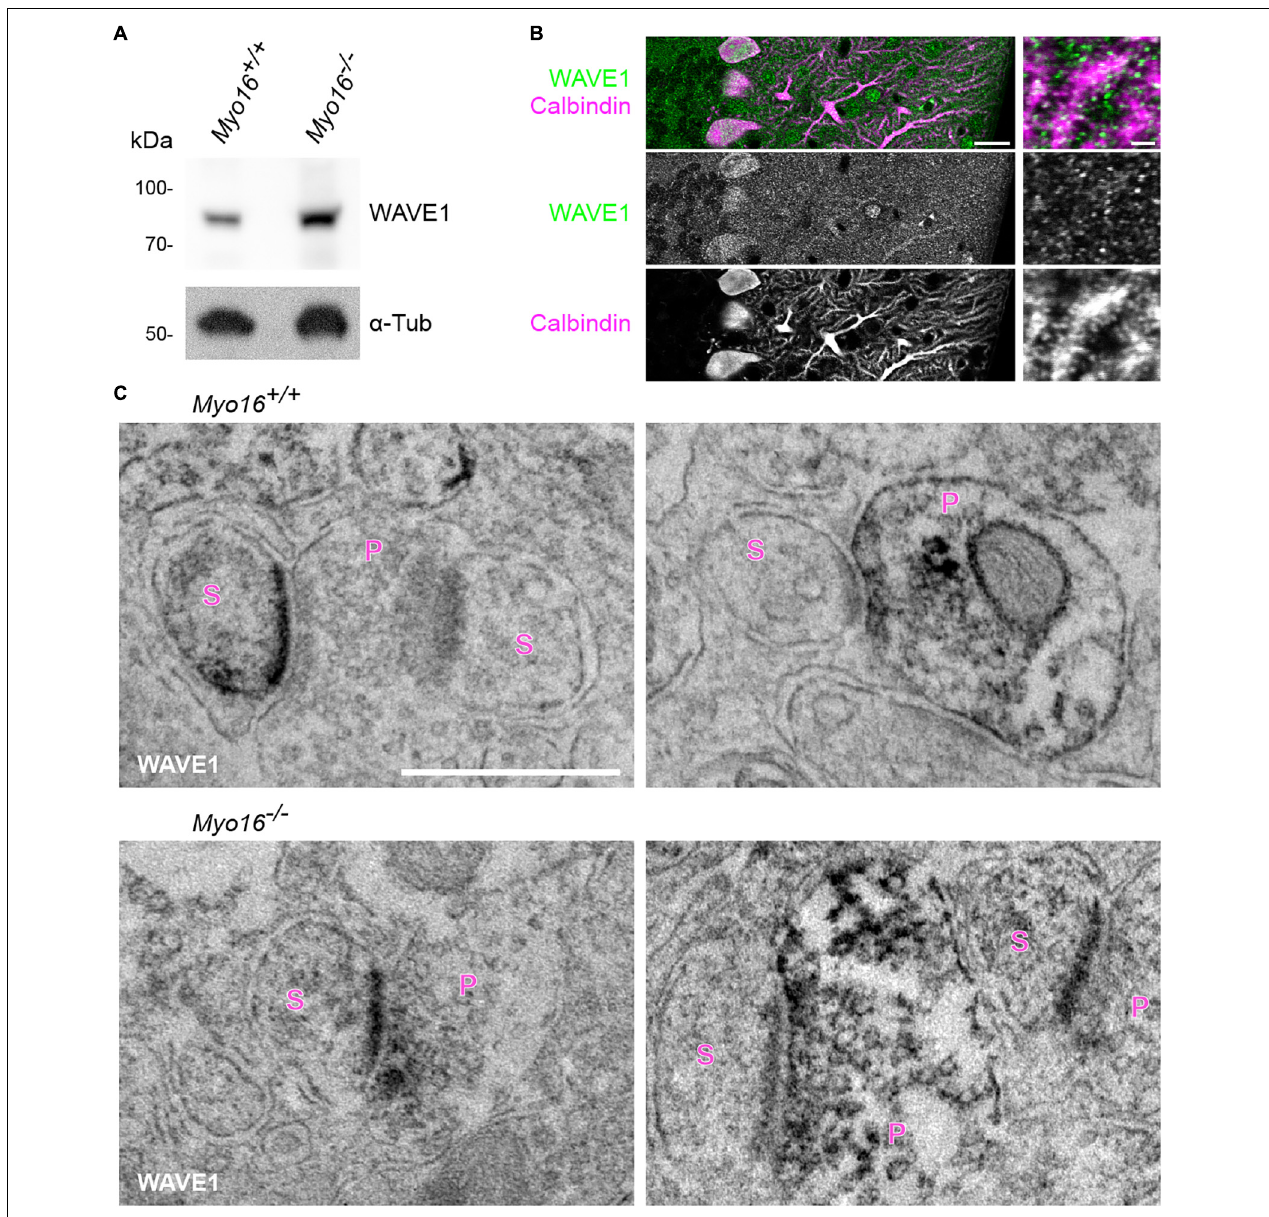
FIGURE 5 | WAVE1 localizes to Purkinje cell spines and to presynaptic terminals in the cerebellar molecular layer. (A) Western blot analysis of cerebellar extracts from 11 day old wild-type ( Myo16 + / + ) and Myo16 em 3 knockout ( Myo16 − / − ) mice. Antibodies against WAVE1 and α -Tubulin ( α -Tub; loading control) were used. (B) WAVE1 partially co-localizes with PC spines. Confocal images of cerebellar sections from adult wild type mice immuno-fluorescently labeled with antibodies against WAVE1 and Calbindin-D-28K. Right panels are zoom-in images depicting the molecular layer. Scale bars, 20 µ m (right panels); 2 µ m (left panels). (C) Immuno-electron microscopy of cerebellar sections from adult wild-type mice ( Myo16 + / + ; upper panels) and Myo16 em 3 knockout mice ( Myo16 − / − ; lower panels) using WAVE1 antibody and DAB labeling. Black precipitate indicates presence of WAVE1. Left panels depict examples of PC spines positive for WAVE1, right panels are examples of presynaptic terminals positive for WAVE1. S, spine; P, presynaptic bouton. Scale bar, 500 nm.